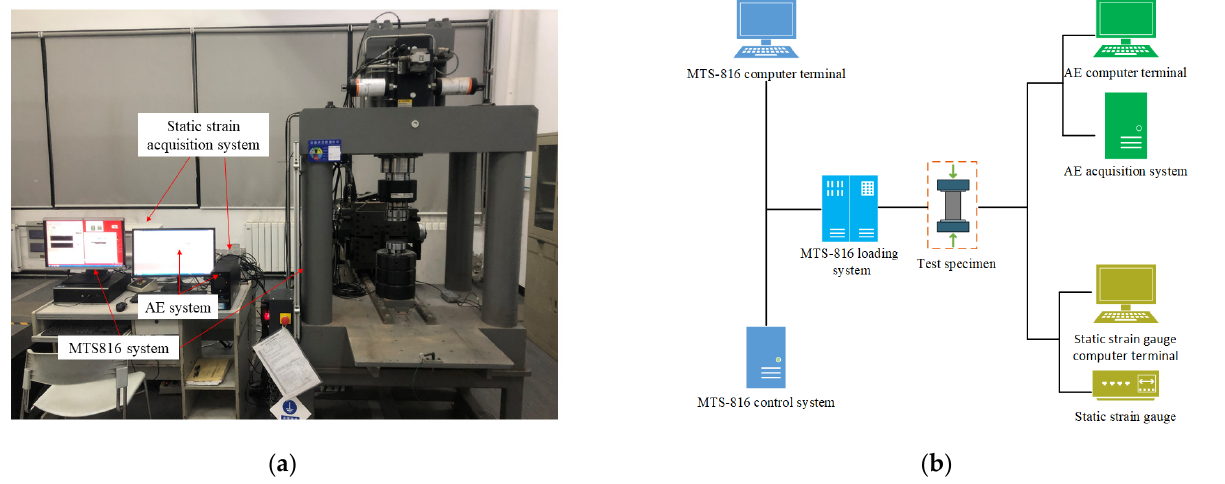
Figure 1. Testing system: ( a ) diagram of testing system; ( b ) layout of testing system.